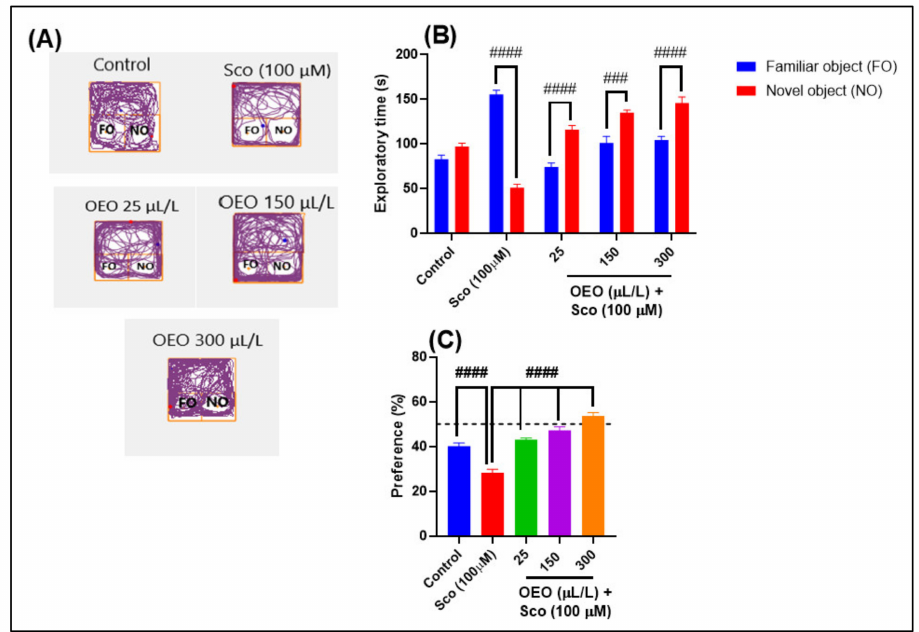
Figure 5. Origanum vulgare ssp. hirtum essential oil (OEO: 25, 150, and 300 µ L/L)-improved memory in the novel object recognition (NOR) test. ( A ): Locomotion tracking patterns of the control, scopo- lamine (Sco: 100 µ M), and OEO (25, 150, and 300 µ L/L)-treated groups; ( B ). The exploratory time (s) in different groups; ( C ). The percentages of preference in different groups. Values are means ± S.E.M. ( n = 10). For Tukey’s post hoc analyses: ### p < 0.0001 and #### p <